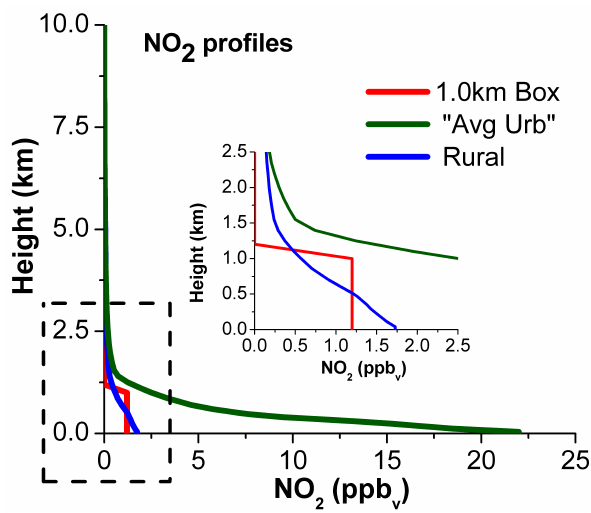
Fig. 2. NO 2 profiles from surface to 10.0km used in the SCIA- TRAN settings for the airmass factor calculations: box profile of 1.0km (red); average urban (“Avg Urb”, green) and rural (blue) based on CHIMERE model